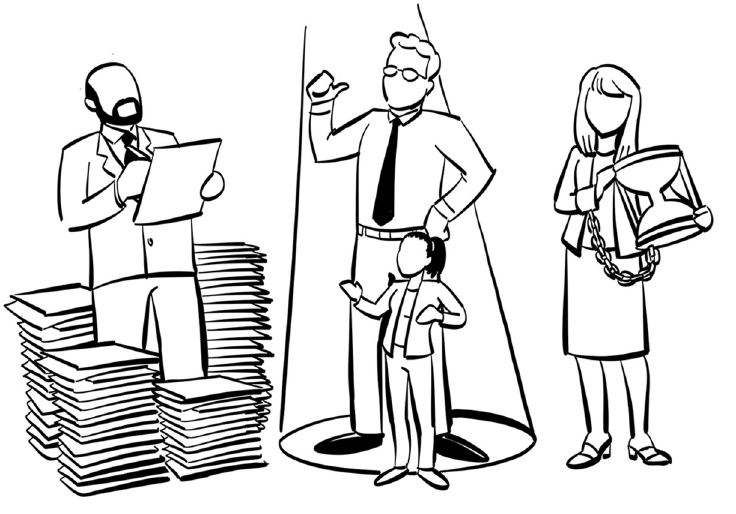
Fig 7. Limelight on the